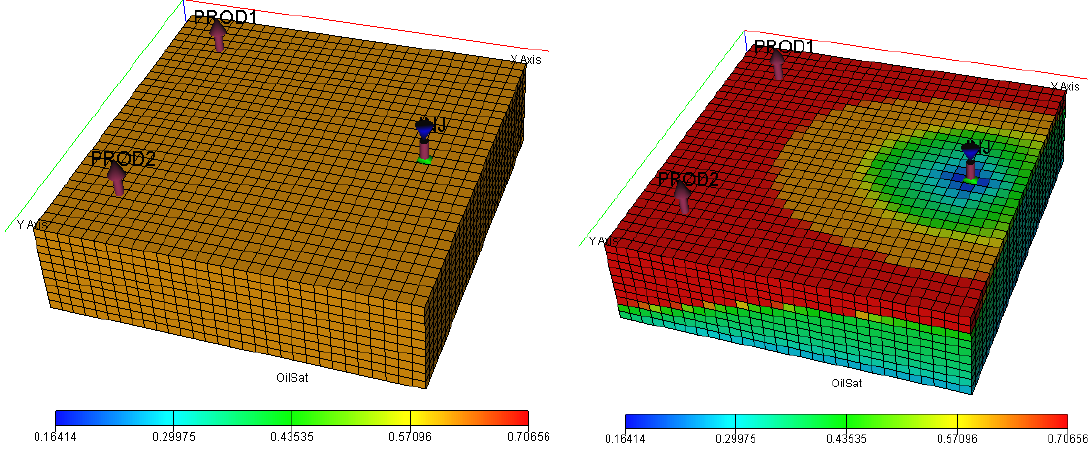
Figure 17. Before ( a ) and after ( b ) simulated 3D oil